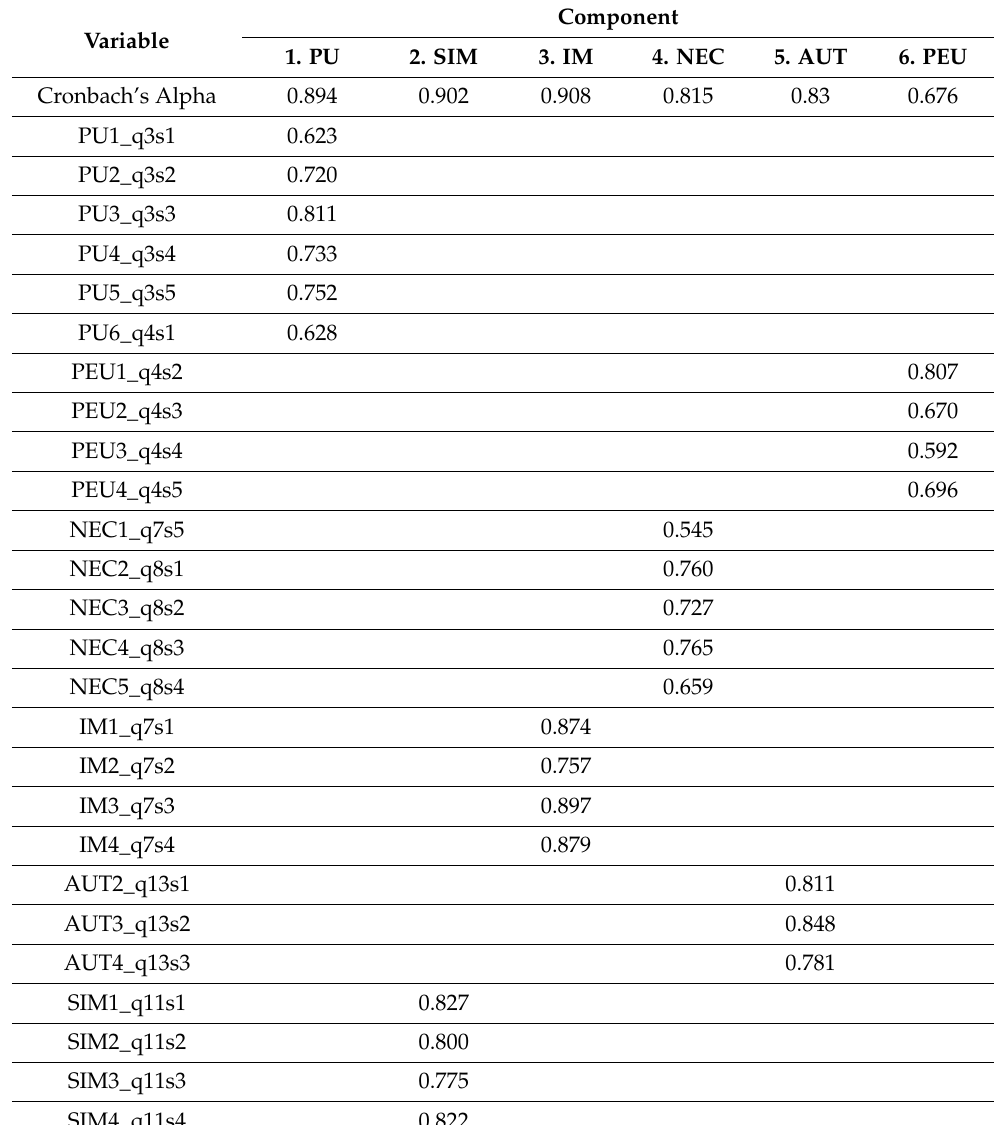
Table 5. Rotated Component Matrix